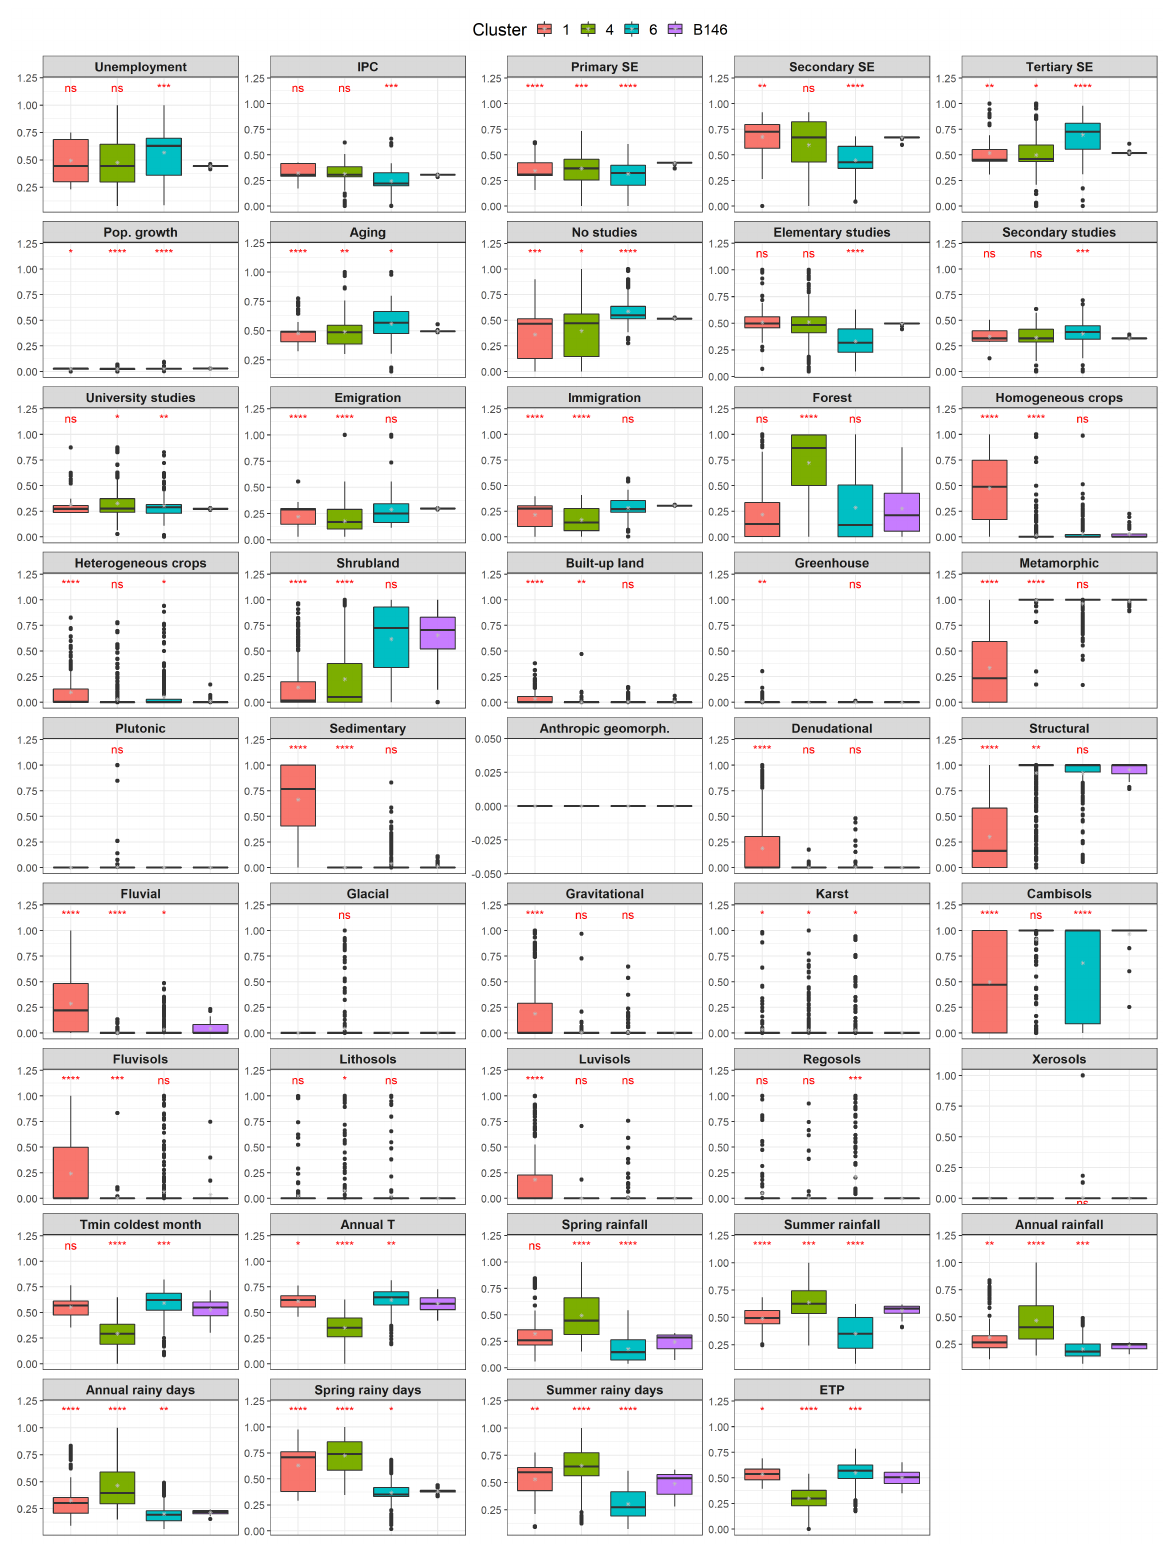
Figure A6. Comparison of the socio-ecological variables between Sectors 1, 4 and 6 and the boundary among them (B146). Statistical significance is shown as: ns: p -value > 0.05; *: p -value ≤ 0.05; **: p -value ≤ 0.01; ***: p -value ≤ 0.001; ****: p -value ≤